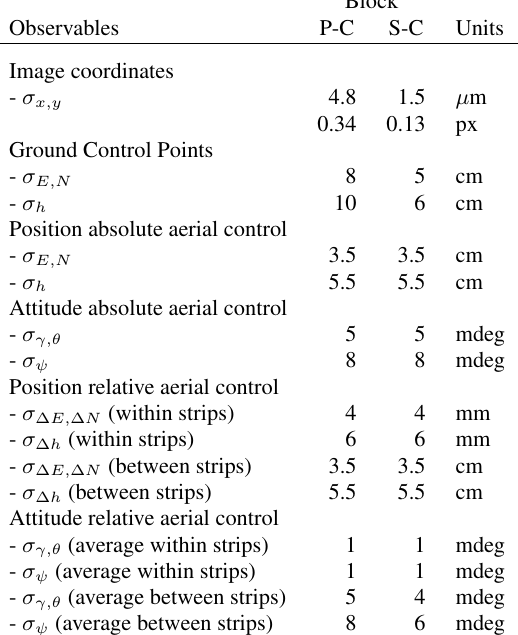
Table 4: Test blocks: precision of observables. number of images, strips, sub-blocks, GCPs and image obser- vations of these GCPs. Because of the available Pavia and Salou block data, the Pavia and Salou corridors are composed by 3 flight lines. In the interest areas, there are 7 and 8 available GCPs for Pavia and Salou corridor, respectively. Therefore, the three pos- sible Fast AT geometries of Pavia corridor and Salou corridor are represented in Figure 1 and Figure 2,